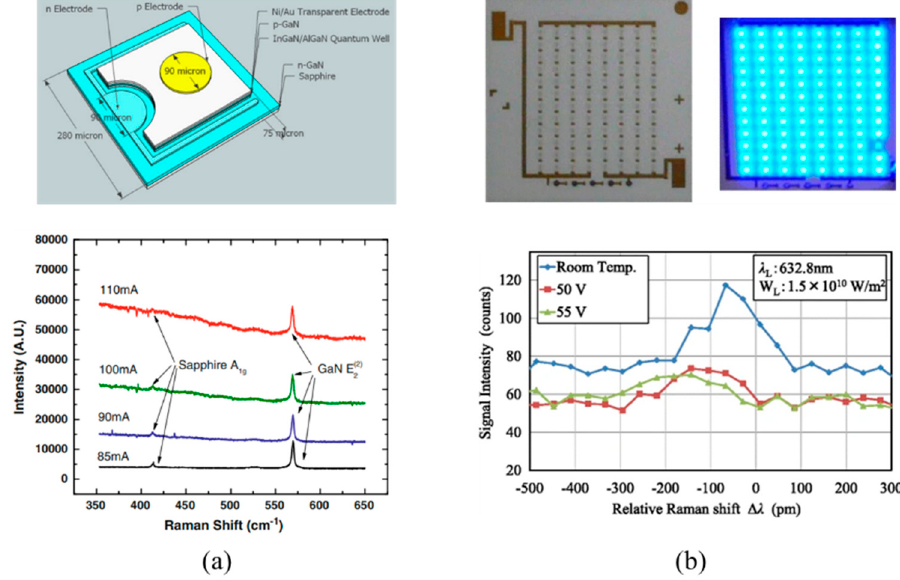
Figure 10. ( a ) Junction temperature determination of UV LED with micro-Raman spectroscopy. The structure of the UV LED chip is shown in the upper figure, while the E 2(2) Raman peaks at different input currents are shown at the bottom. Reprinted with permission from Ref. [162]. Copyright 2010, Springer Nature. ( b ) Junction temperature estimation of a blue LED using pulsed laser Raman scattering. Measured LED package is shown in the upper figure, while a Raman spectra of the E 2 at different input voltages is shown at the bottom Reprinted/adapted with permission from Ref. [168]. Copyright 2015, Springer Nature. Table 3. Raman spectroscopy parameters that are employed in the literature for T j measurement of LEDs. References are sorted by year. Not reported parameters are indicated by a hyphen in the table. ( λ : wavelength).